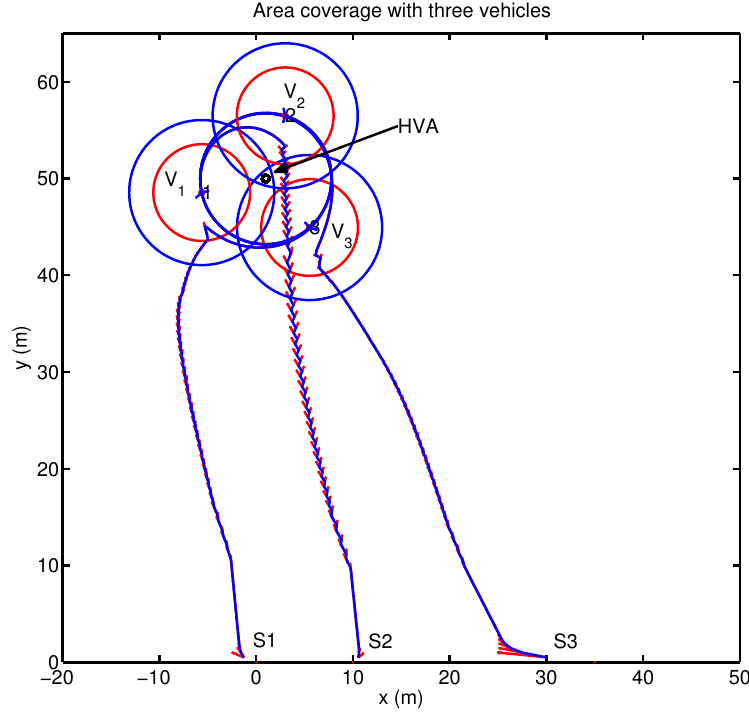
Figure 6. Area coverage performance with three vehicles. The optimal locations for the agents to obtain the total coverage of a circle of radius R are the vertices of the inscribed M triangle. A circular motion is stimulated when each vehicle communicates its foreseen location at its next communication step. For each agent, bold lines are used to depict both the ( RM > RD ) . maximum distance allowed R and the detection sonar maximum range R M D Red arrows indicate the vehicles